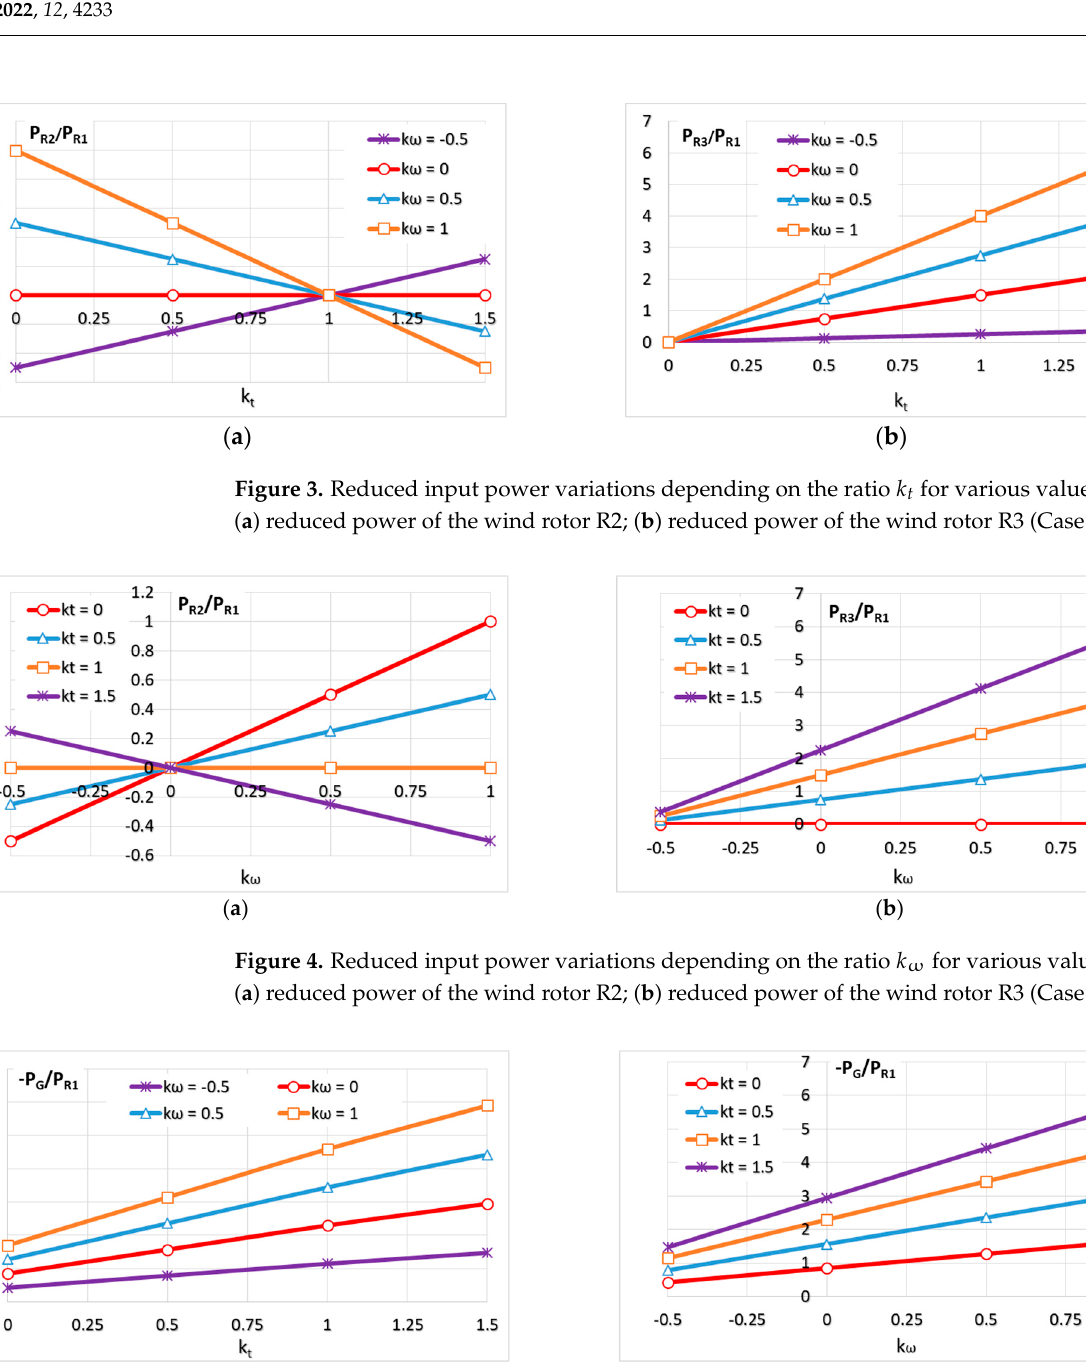
Figure 5. Variations of the electric generator reduced power, depending on: ( a ) the ratio k t ; ( b ) the ratio k ω (Case A).